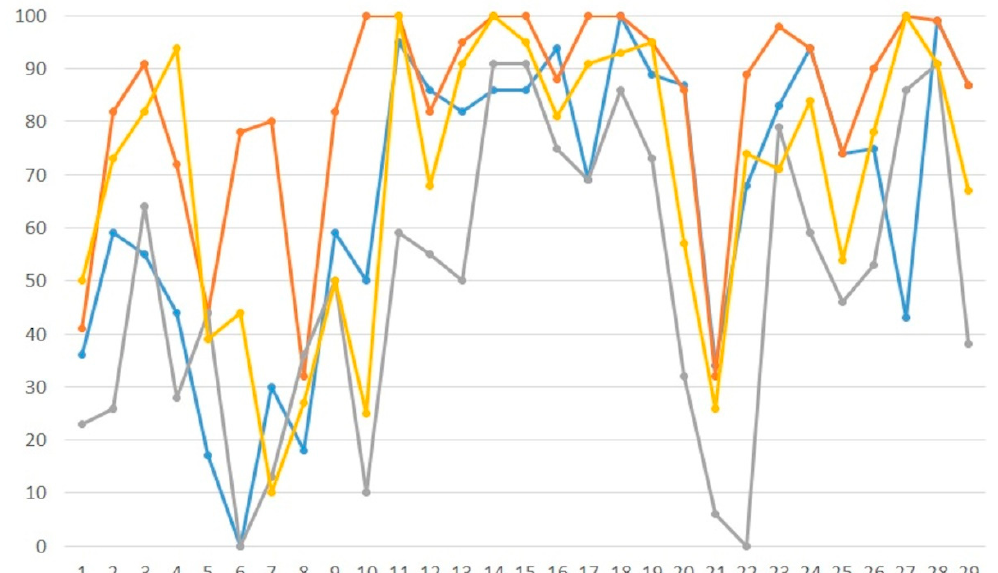
Figure 2. The MA values for NAUTILUS (blue line), CAB (red line), ARP / wARP (grey line) and PHENIX.AUTOBUILD (yellow line). The numbers on the horizontal axis correspond to the order entries of the test structures in Tables 2 and 4.